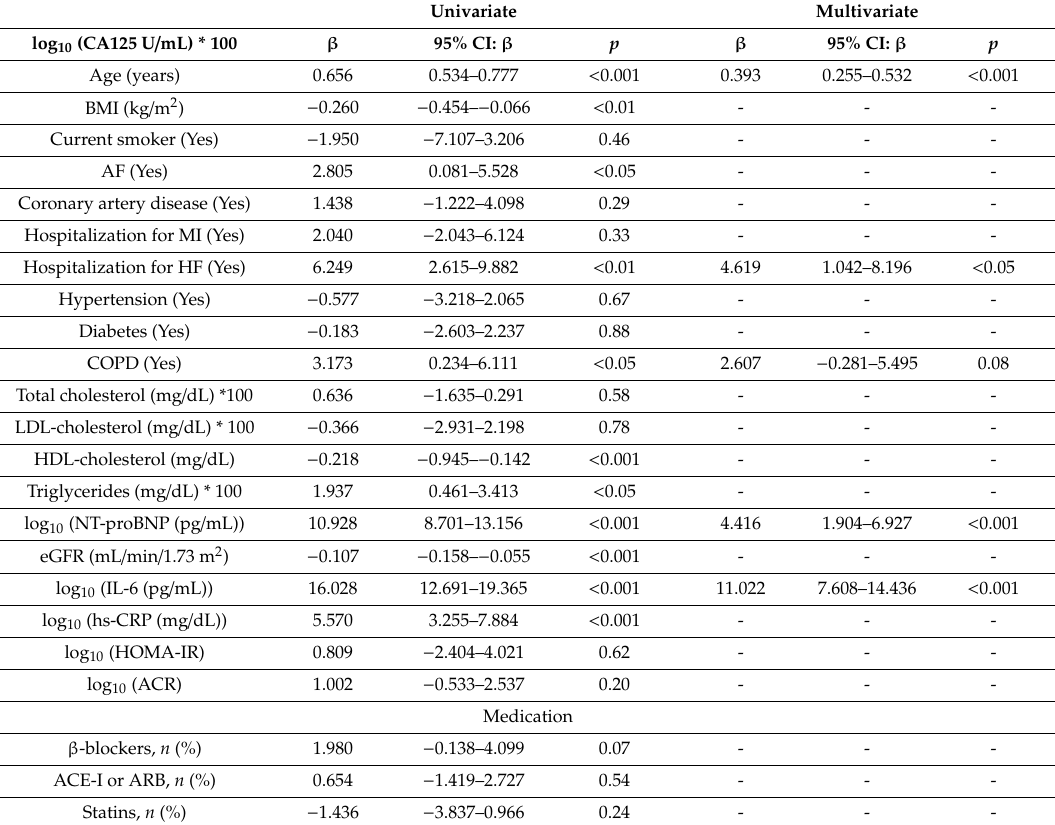
Table 2. Univariate and multivariate, stepwise, backward skew-t regression analyses of factors associated with increased CA125 serum concentrations in older Polish